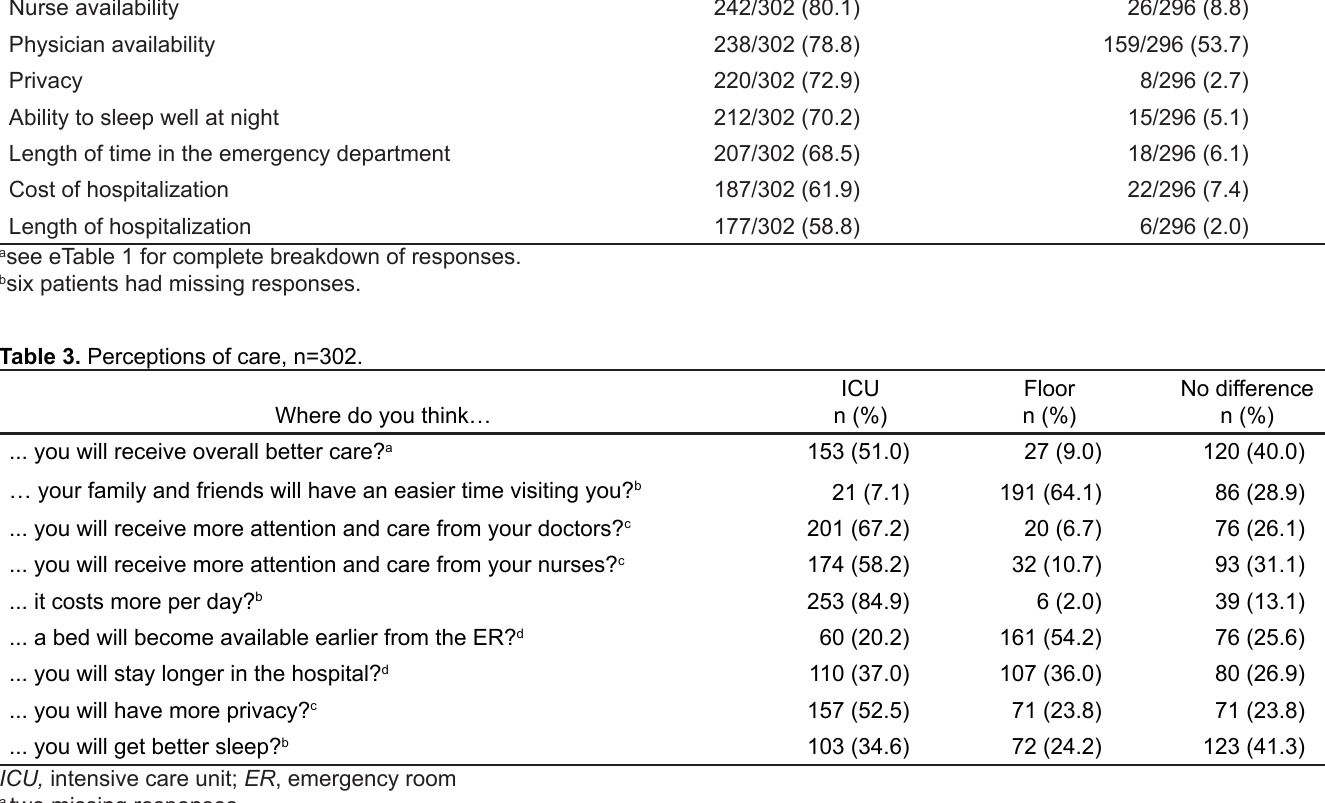
ICU, intensive care unit; ER , emergency room a two missing responses. b four missing responses. c three missing